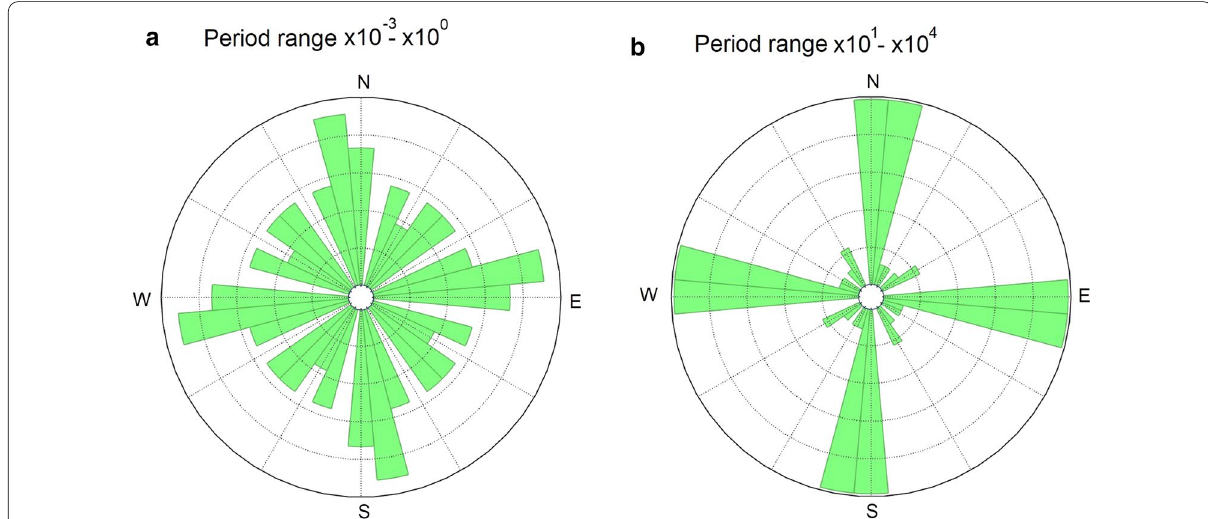
Fig. 2 Geoelectric strike for two period ranges. a The geoelectric strike for sites with periods between 10 − 3 and 10 0 s. b The geoelectric strike for sites with periods between 10 1 and 10 4